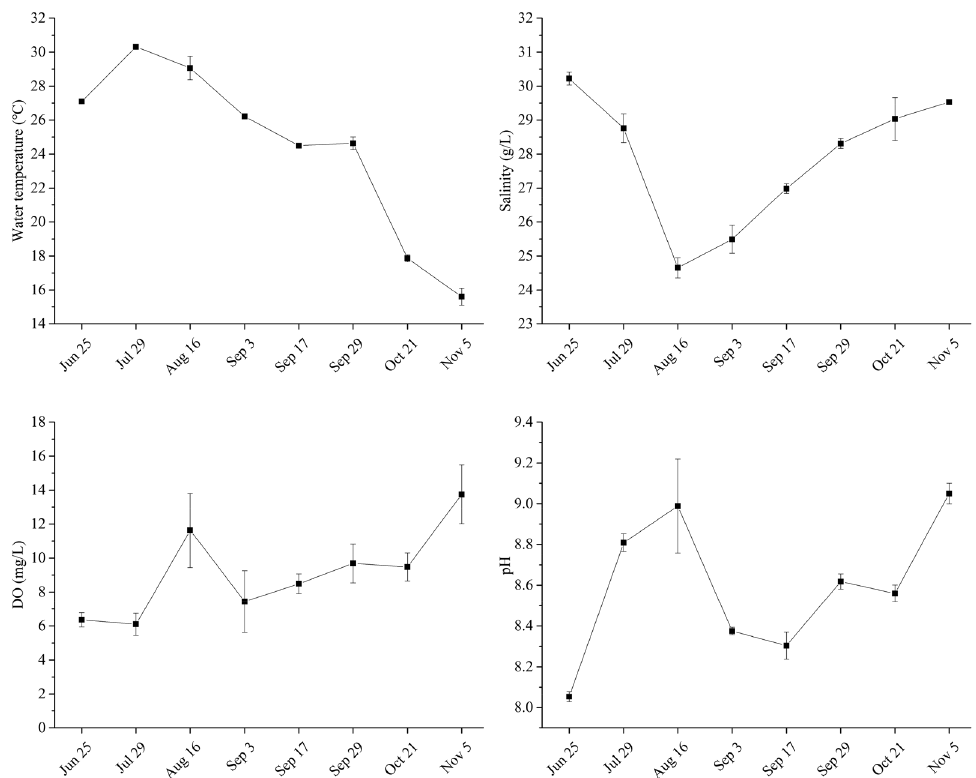
Figure 1. Water quality parameters in the aquaculture pond.